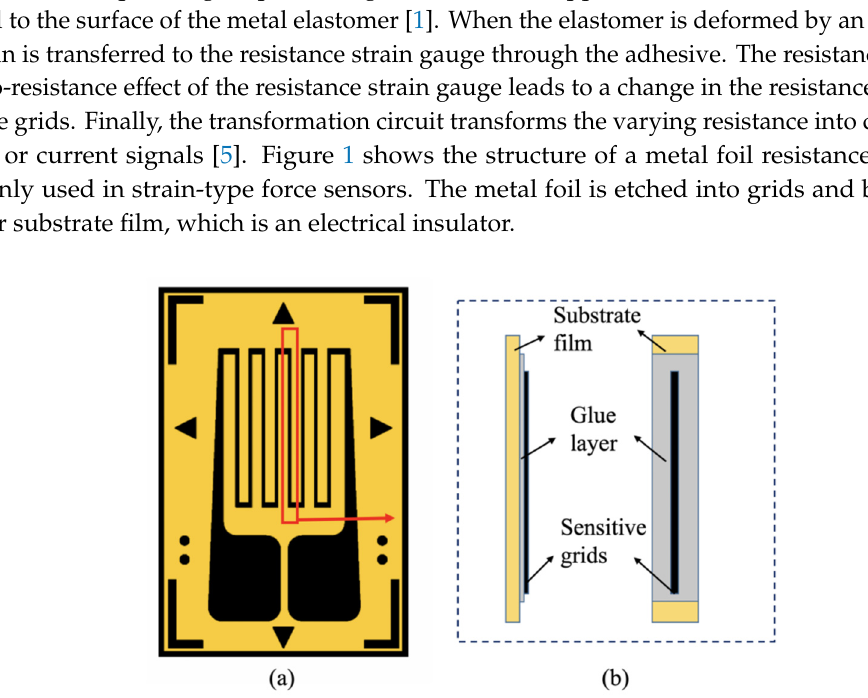
Figure 1. Structure of a metal-foil-type resistance strain gauge: ( a ) top view and ( b ) side view.